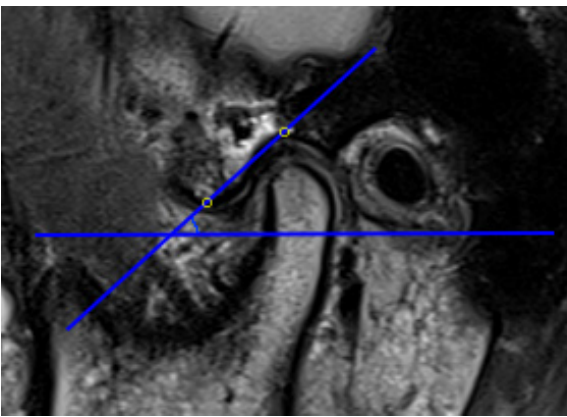
Figure 2. Representative images of “top-roof line” method, the articular eminence inclination (AEI) defined as the angle between the line connecting the crest point of the articular eminence and the roof of the mandibular fossa and the horizontal reference plane.